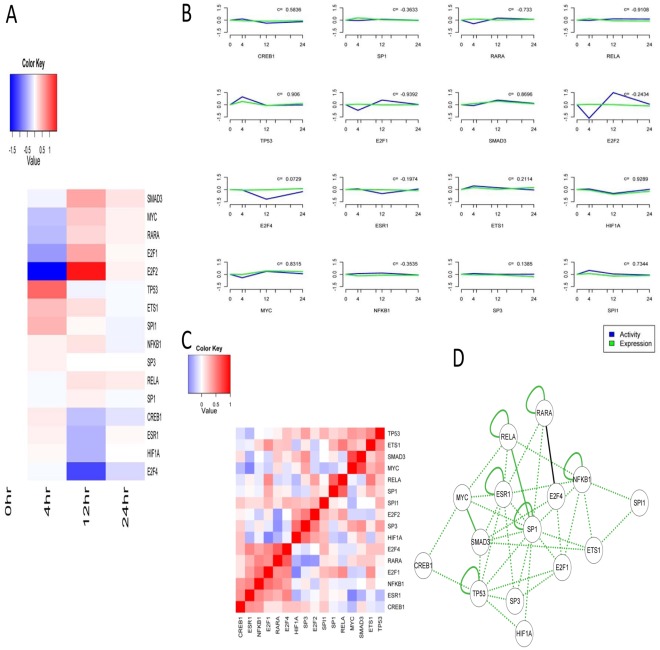
Transcription factor activities calculated using NCA.(A) Predicted activities of the 16 TFs used in this study. Rows represented progression in time and columns corresponded to the activities. Activities of each column were normalized to the zero time point. (B) Transcription factor activities (blue) compared with gene expression (green), with Pearson correlation coefficients noted. Both activity and expression at each time point were averages normalized to the time zero values. (C) Correlation matrix between transcription factor activities. Red represented positive correlation and blue represented negative correlation. (D) Inferred combinatorial regulation pairs of TFs. Green solid line indicated that the pair was supported by protein-protein interaction information from HPRD, BIOGRID and high correlation of their activities (>0.6). Black solid line indicated that the pair was only supported by high correlation, and a green dotted line indicated that the pair was only supported by the interaction database.